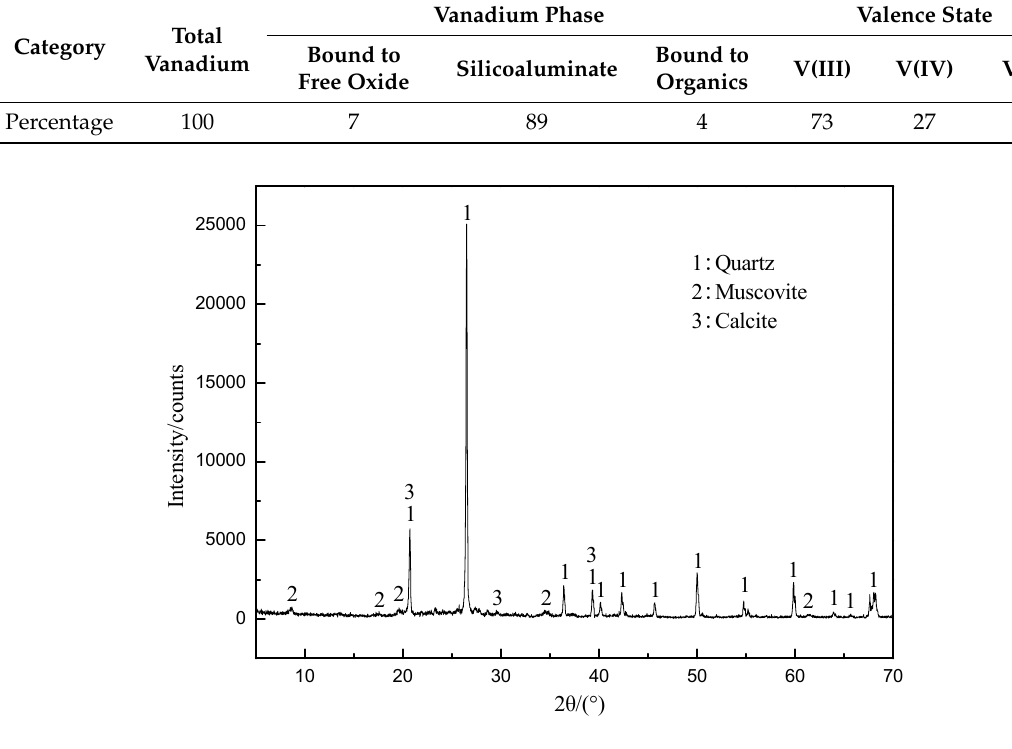
Figure 1. XRD pattern of the raw ore.